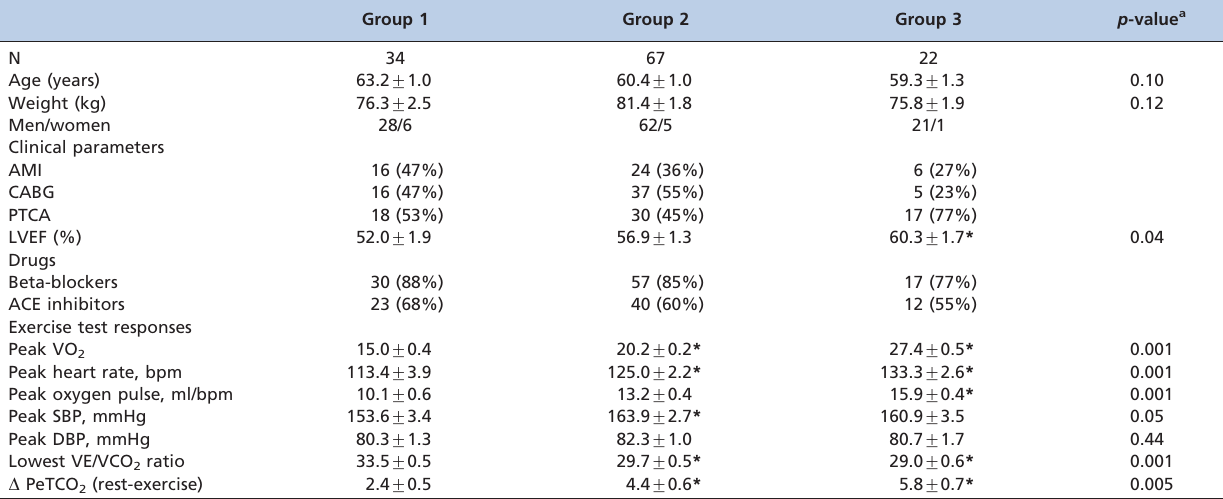
Table 1 - Patient